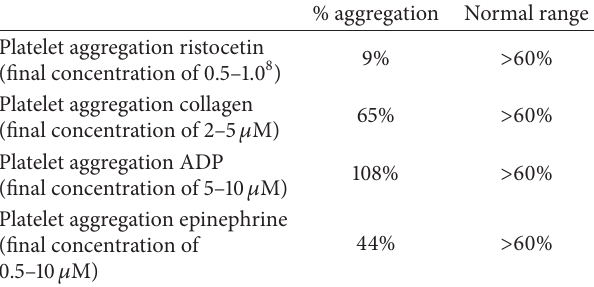
Table 1: Platelet